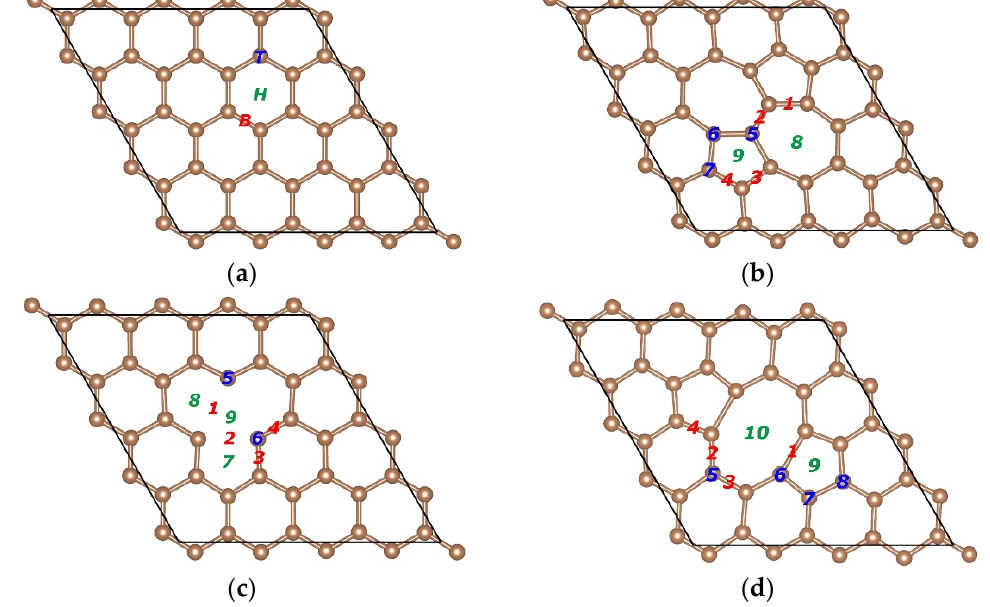
Figure 1. Structure of the pristine graphene, the Stone–Wales (SW) defect graphene, the single vacancy (SV) graphene, and the double vacancy (DV) graphene prepared for density function theory (DFT) calculations and adsorption sites on graphene. ( a ) Bridge (red), Top (blue), and Hollow (green) on the pristine graphene. ( b ) Bridge 1–4, Top 5–7, and Hollow 8–9 on the SW defect graphene. ( c ) Bridge 1–4, Top 5–6, and Hollow 7–9 on the SV graphene. ( d ) Bridge 1–4, Top 5–8, and Hollow 9–10 on the DV graphene.